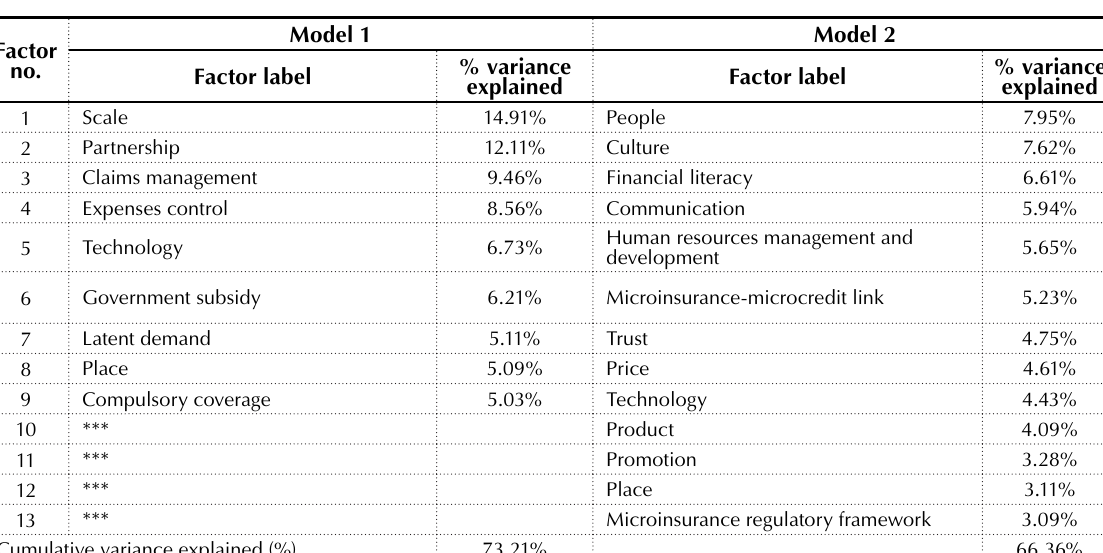
Table 2. Factors of the